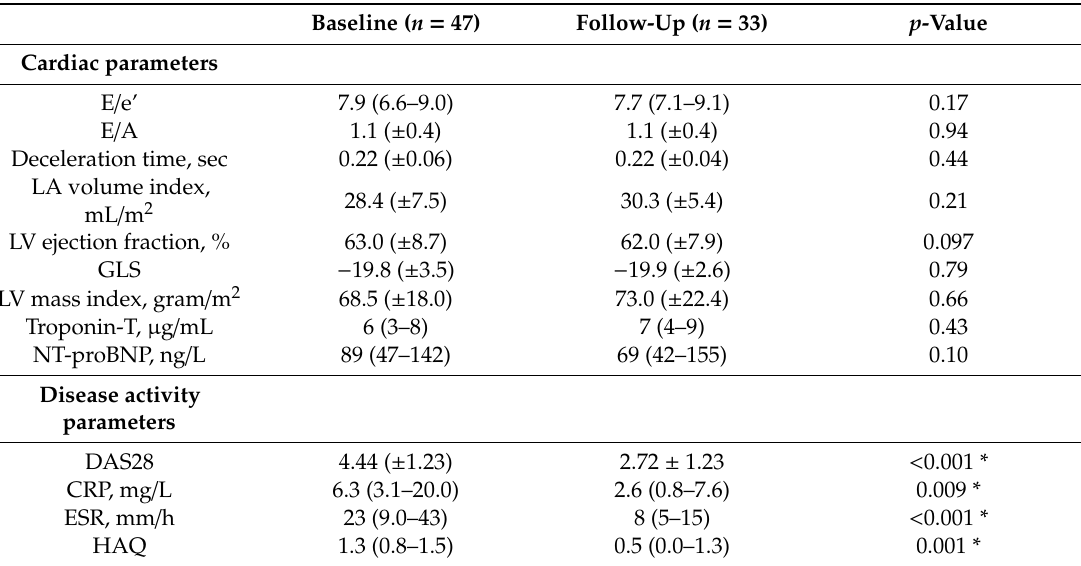
Table 2. E ff ect of anti-TNF on the cardiac parameters and disease activity parameters.